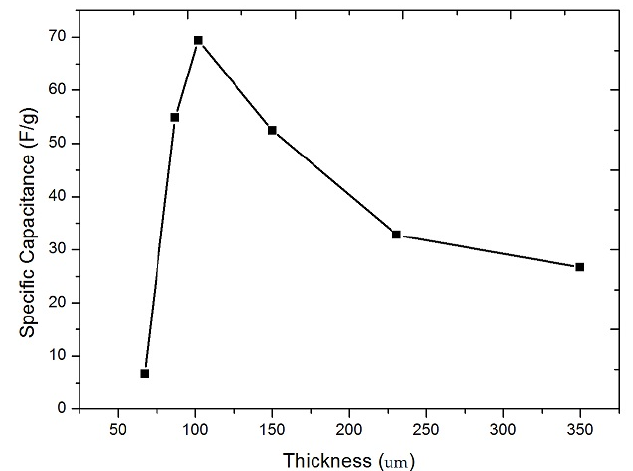
Figure 4. SEM images of cross-section and histograms showing the distribution of measured thick- ness of electrodes of an initial thickness of the wet film of ( a ) 200 μ m, ( b ) 400 μ m and ( c ) 600 μ m.